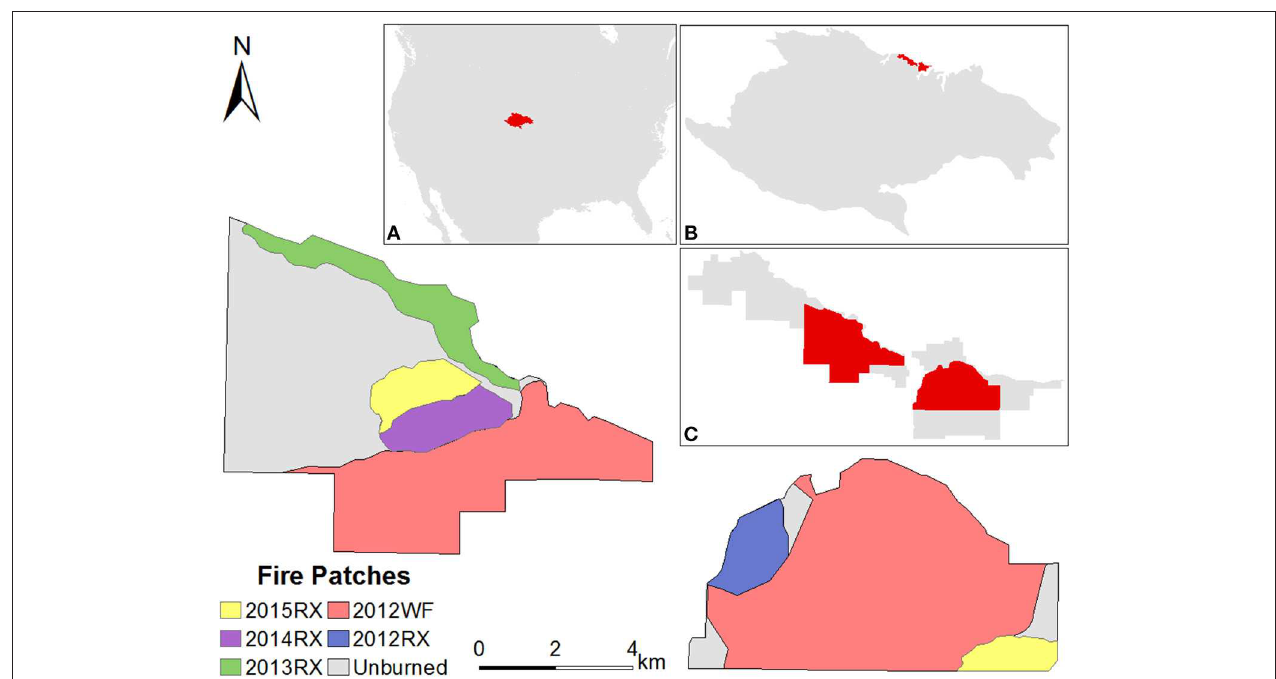
FIGURE 1 | Fire was applied in patches on two continuous Nebraska Sandhills grassland landscapes characterized as homogeneous in vegetation structure and composition after long-term “management for the middle.” RX represents patches burned using prescribed fire in March (2015RX, 2013RX, and 2012RX) and September (2014RX) of each respective year. WF represents the Fairfield Creek Wildfire that burned in July 2012. The unburned patch did not burn in the time period between 2012 and the end of the study. Bison have unrestricted access to all fire patches within each unit. Insets illustrate the location of (A) the Nebraska Sandhills in central North America, (B) the Niobrara Valley Preserve in the Nebraska Sandhills, and (C) the contiguous bison units at the Niobrara Valley